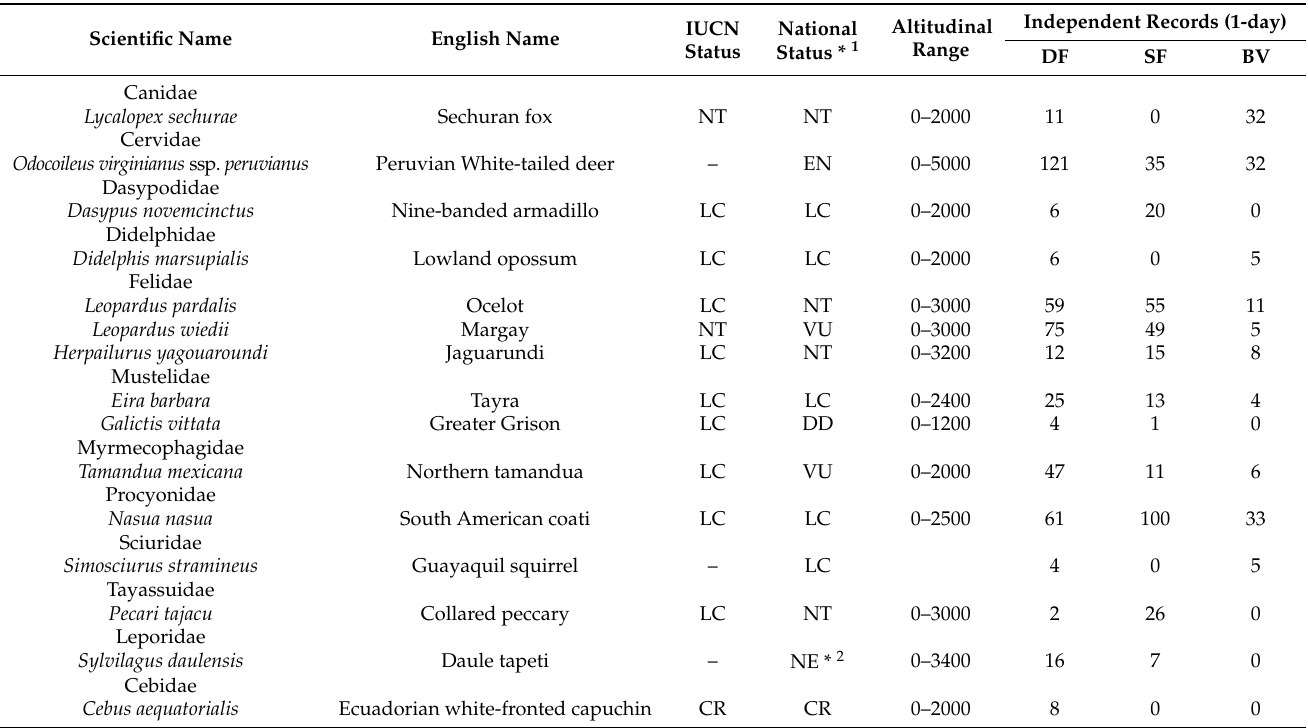
Table 2. Recorded mammal species with IUCN and national conservation status. In order of conservation status acronyms mean: DD = Data deficient, LC = Least concern, NT = Near-Threatened, VU = Vulnerable, EN =